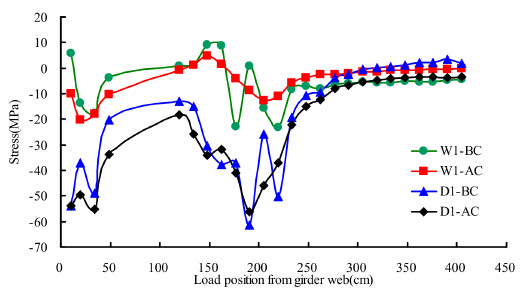
Figure 13. Hotpot stresses of girder web-to-deck under transverse wheel